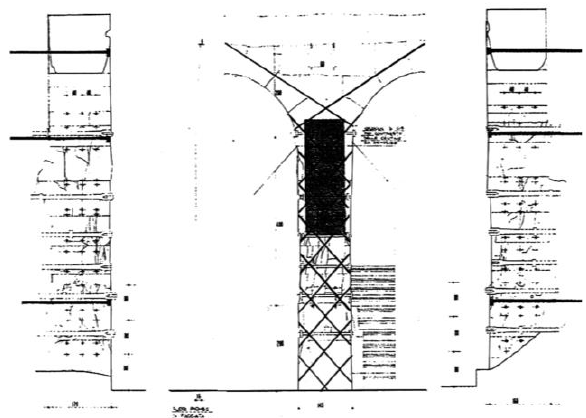
Figure 8. Drawing of the retrofit intervention project about the transversal and frontal perforations of the travertine columns and arches necessary for the insertion of the